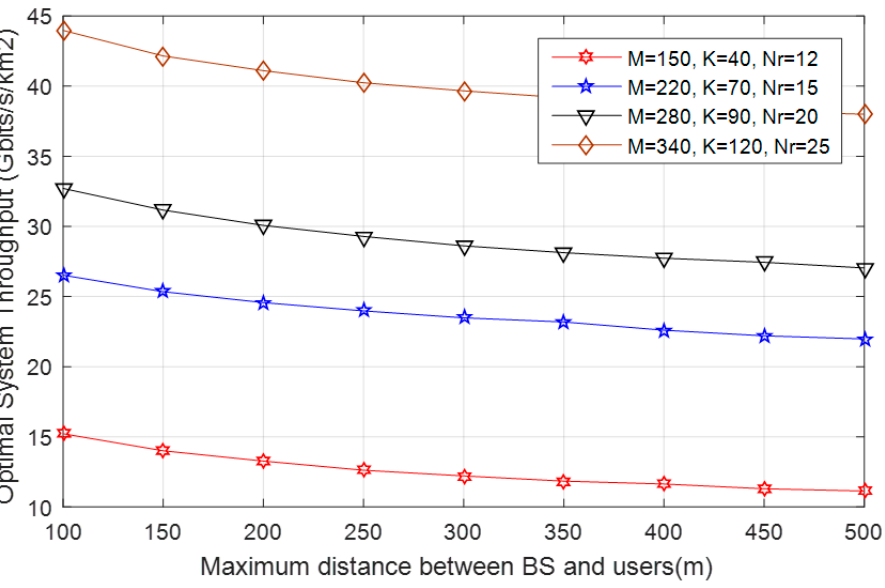
Figure 5. Optimal system